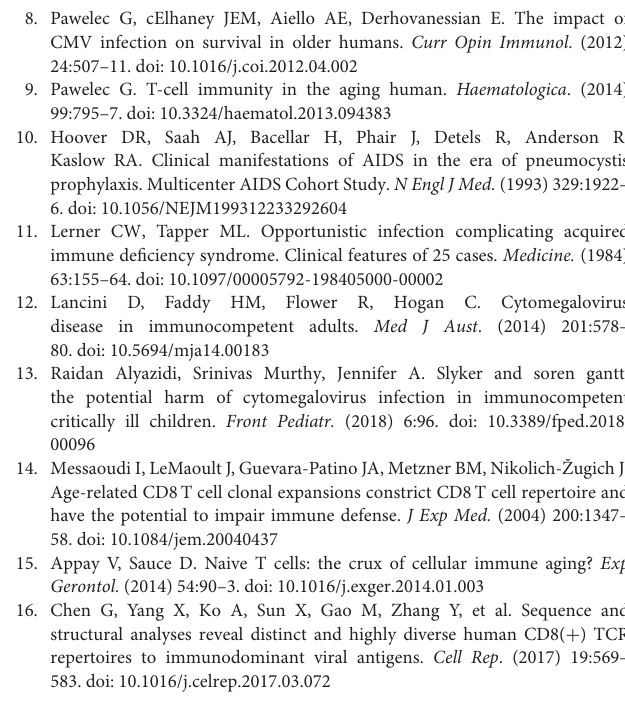
curve reaches saturation after 10M reads, indicating that no new TCR clonotypes are detected with the inclusion of additional sequencing reads. Supplementary Figure 2 | Assessment of sample bias and noise in high-throughput sequencing of TCR-beta chains. The number of sorted tet + cells does not correlate with TCR-beta (A) richness, (B) entropy, or (C) evenness. The number of processed reads does not correlate with TCR-beta (D) richness, (E) entropy, or (C) evenness. Supplementary Figure 3 | NW8 tetramer staining and CCR7/CD45RA differential expression. Representative flow cytometry plots are shown for every mother child pair: (A) 64C and 64M; (B) 76C and 76M; (C) 35C and 35M; (D) 21C and 21M. In each panel, HLA-B ∗ 44:03-NW8 tet + CD8T cells (gated on live CD3-positive T cells) are shown on the left. CCR7 vs. CD45RA expression is shown on the right. Supplementary Figure 4 | T cell activation and exhaustion in NW8-specific responses fluctuates over time. Longitudinal phenotypic T cell data are shown for (A) 64C and 64M, (B) 35C and 35M, (C) 76C and 76M. In each panel, HLA-DR expression (top row), PD-1 expression (upper middle row), and the frequency of T EMRA cells (CD45RA + CCR7 − ; lower middle row) and T EM cells (CD45RA − CCR7 − ; bottom row) are shown for tet + and bulk CD8T cells. Data from the children is displayed in dark green for tet + and light green for bulk CD8T cells (left side). Data from the mothers is in black for tet + , or grey for bulk CD8T cells (right side). Supplementary Figure 5 | TCR- α and – β chain usage in a HIV-negative subject. TRAV-TRAJ (left) and TRBV-TRBJ (right) gene co-occurrence wheels are shown for patient 64S, a HIV-negative sibling of 64C. The size of the arcs is proportional to V or J frequency. The area joining any V-J pair is proportional to the co-occurrence frequency of that pair. Co-occurrence (“circos”) wheels were generated by VDJviz ( 40). Gene segments encoding dominant clonotypes are highlighted in colors matching the corresponding section in the wheel. Supplementary Figure 6 | TCR richness and diversity. Absolute repertoire richness is given by the total number of clonotypes and plotted as a function of age for the TCR- α (A) and the TCR- β chain (B) . TCR diversity was calculated as outlined in Materials and methods and displayed for TCR- α in (C) and TCR- β in (D) . Supplementary Table 1 | Antibodies used in the present